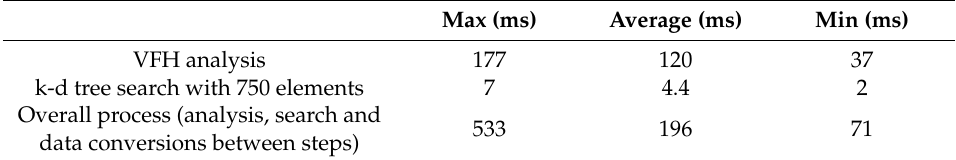
Table 6. Times required for different steps of the gesture analysis and classification process.